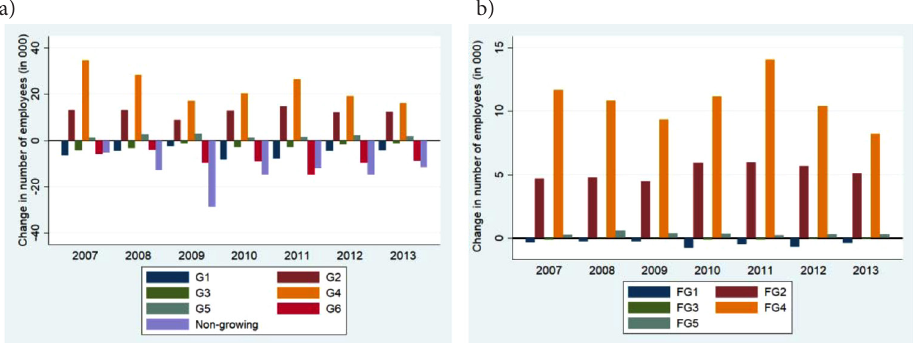
Figure 3. (a) Year-on-year change in the no. of employees by groups of growing firms (left); (b) year- on-year change in the no. of employees by groups of fast-growing firms